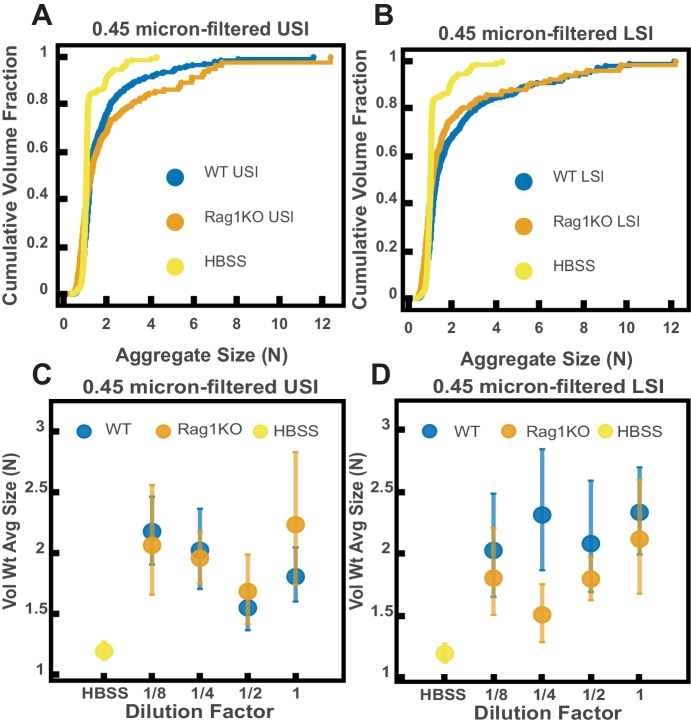
Ex vivo aggregation in 0.45-µm-filtered luminal fluid from the small intestines (SI) of wild-type (WT) and Rag1 knockout (Rag1KO) mice.(A and B) Volume-weighted empirical cumulative distribution functions (ECDFs) comparing aggregation of the particles in undiluted, 0.45-µm-filtered samples from the upper (A) and lower (B) SI of two separate groups of WT and immunoglobulin-deficient (Rag1KO) mice to the control (particles suspended in HBSS). Plotted on the vertical axis is the cumulative volume fraction of the total number of particles in solution in an aggregate of a given size. Plotted on the horizontal axis are aggregate sizes in number of particles per aggregate (N). (C and D). Volume-weighted average aggregate sizes (Vol Wt Avg Size) for serial dilutions of 0.45-µm-filtered samples from the upper (C) and lower (D) SI of two separate groups of WT and Rag1KO mice. Volume-weighted average sizes are plotted on the vertical axis in terms of number of particles per aggregate (N). The dilution factor is plotted on the horizontal axis, where a dilution factor of 1 is undiluted and ½ is a two-fold dilution. The control (particles suspended in HBSS) is plotted as a dilution factor of 0. The vertical error bars are 95% empirical bootstrap CI using the bootstrapping procedure described in Materials and methods.